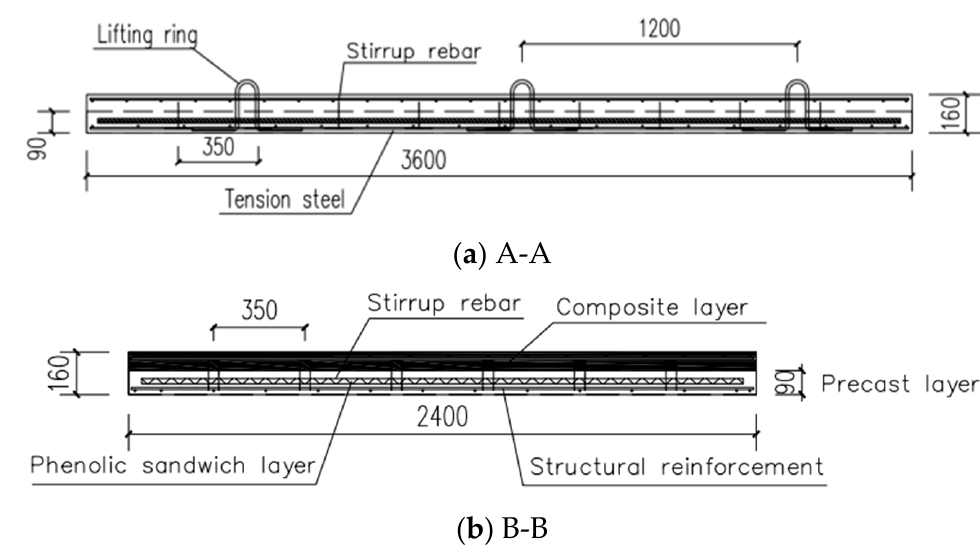
Figure 4. Section diagram of sandwich laminated floor slab. ( a ) Section A-A of floor slab; ( b ) Section A-A of floor slab (unit: mm).